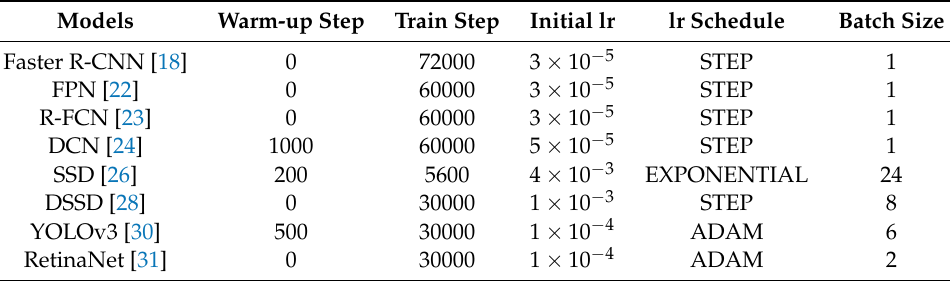
Table 2. Details of eight models. lr, learning